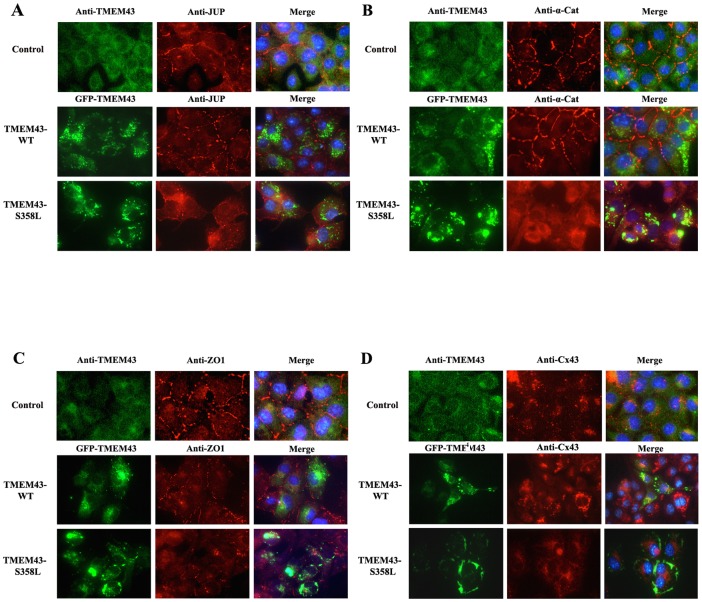
Immunofluorescent staining of TMEM43 and IC disc proteins in HL-1 cells stably expressing wild-type and mutant TMEM43.
A. Immunostaining of Plakoglobin (JUP) was predominantly at the cell-cell border in control and TMEM43-overexpressing (TMEM43-WT) cells, but this significantly decreased at cell border in mutant TMEM43-transfected cells (TMEM43-S358L), with a diffuse expression throughout the cytoplasm instead. TMEM43 (green) was seen in the cytoplasm, as small spots in the TMEM43-WT cells. Greater cytoplasmic distribution was seen in control cells and near the cell edge in the TMEM43-S358L cells. B. α-catenin labeling clearly localized to the border of the cells in control and TMEM43-WT cells but in the TMEM43-S358L cells, α-catenin was clearly located diffusely throughout the cytoplasm, with very little staining specifically at the cell border. C. Immunostaining of ZO-1 labeling showed ZO-1 localization predominantly at the cell-cell junction in control and TMEM43-WT cells, while reduced amounts of ZO-1 were observed in TMEM43-S358L cells. D. Cx43 staining in TMEM43-WT cells demonstrates strong immunoreactive signals at the periphery of the cells and in the cytoplasm which is greater than those levels seen in control cells. In TMEM43-S358L cells, there is diffuse Cx43 staining of the cells throughout the cytoplasm. Images combining the TMEM43 staining/GFP fluorescence with these 4 different proteins (Merge) are shown in the right column including nuclear DAPI staining (blue). All results are representative of three independent cell culture experiments.